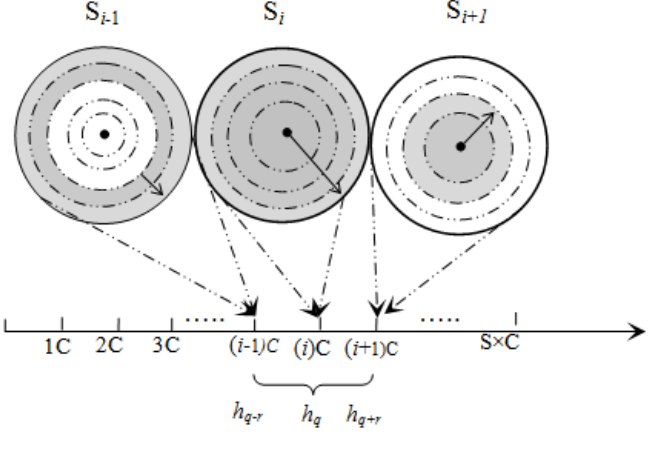
Figure 8. Range query